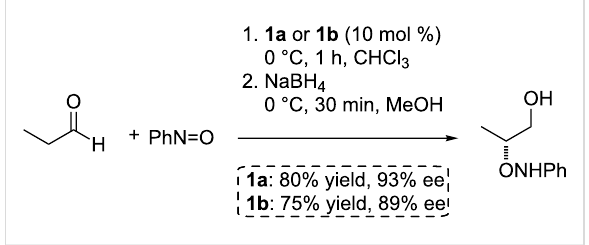
Scheme 3: Direct enantioselective α -aminoxylation of propanal cata- lyzed by resins 1a and 1b